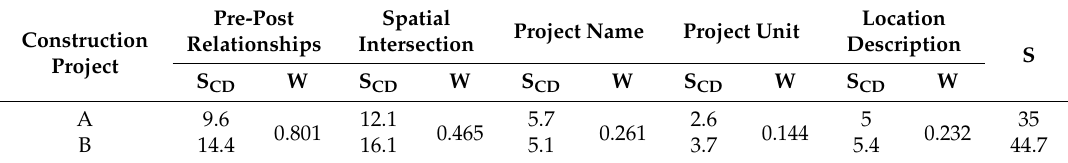
Table 7. The general correlation scores of the two construction